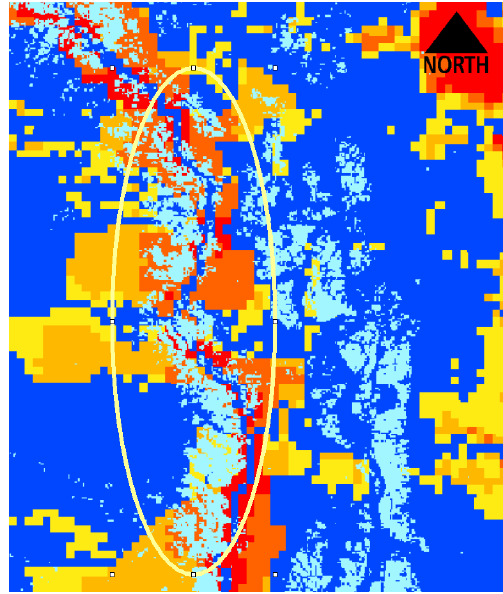
Figure 11. Detail of artifact along the river in the HAND index 3 Fig. 11. Detail of artifact along the river in the HAND 4